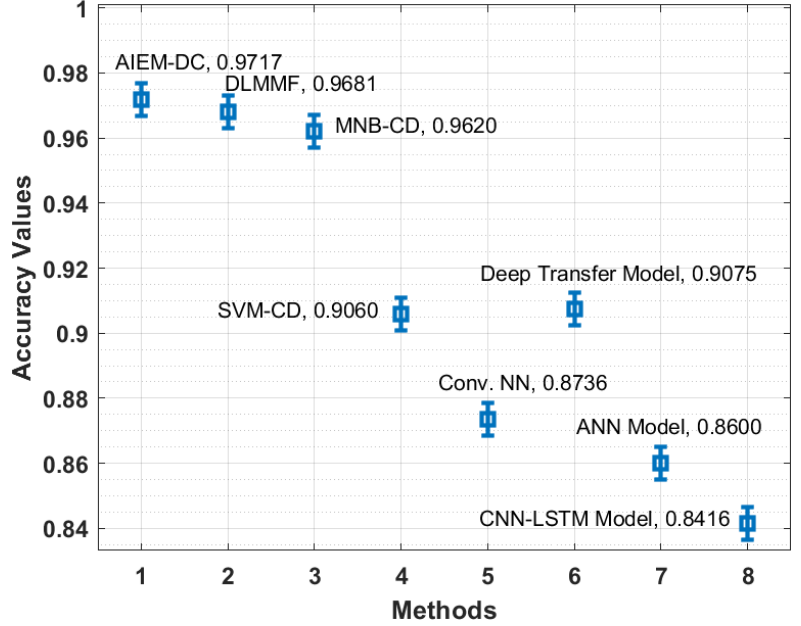
Figure 8. Accuracy analysis of the AIEM-DC model with existing approaches.